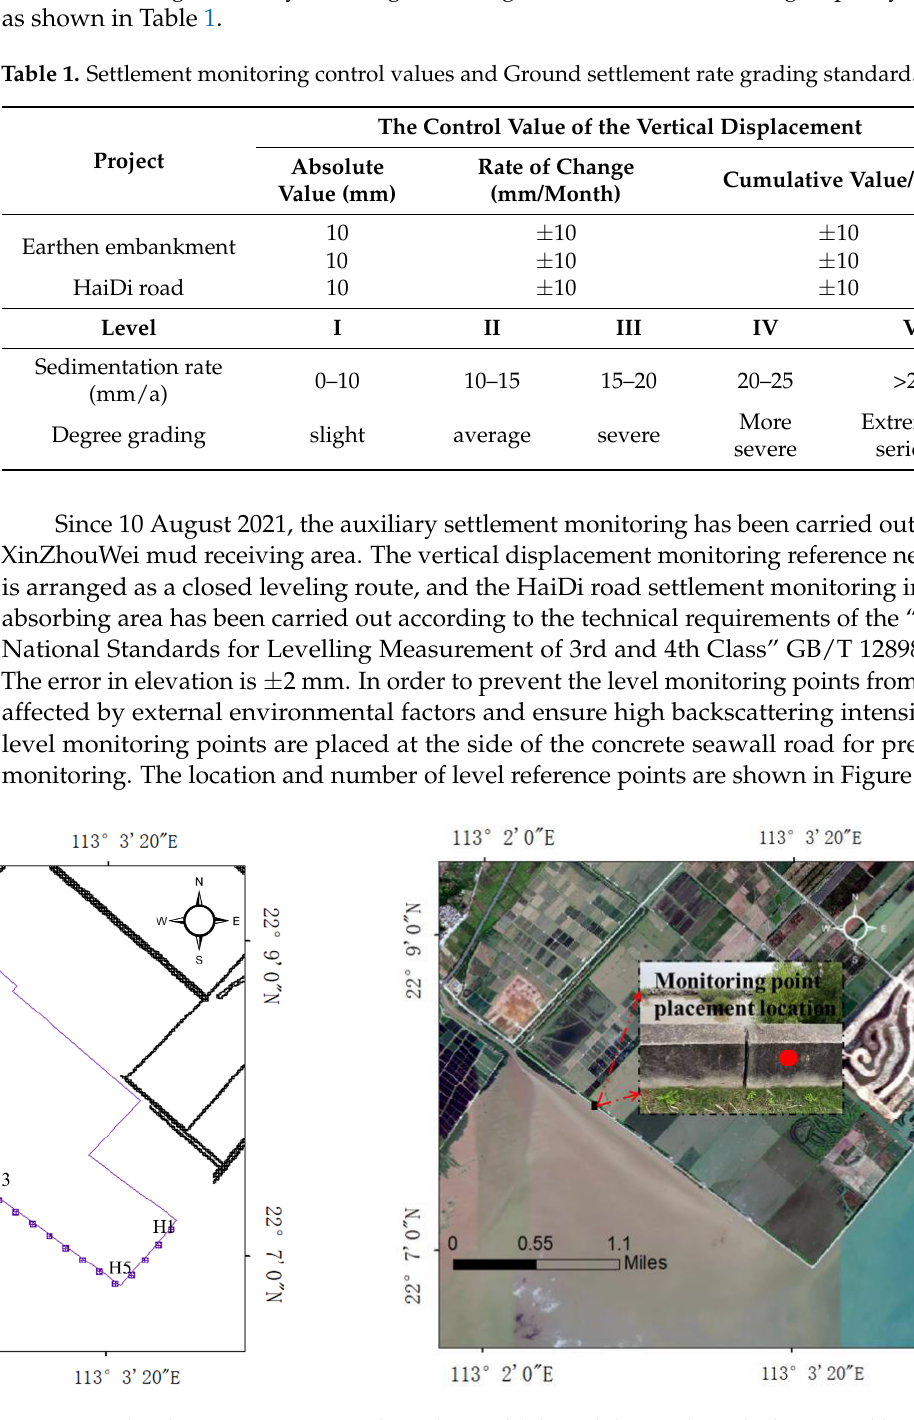
Figure 2. 21 level monitoring points along the road (The red dot is where the horizontal base point is